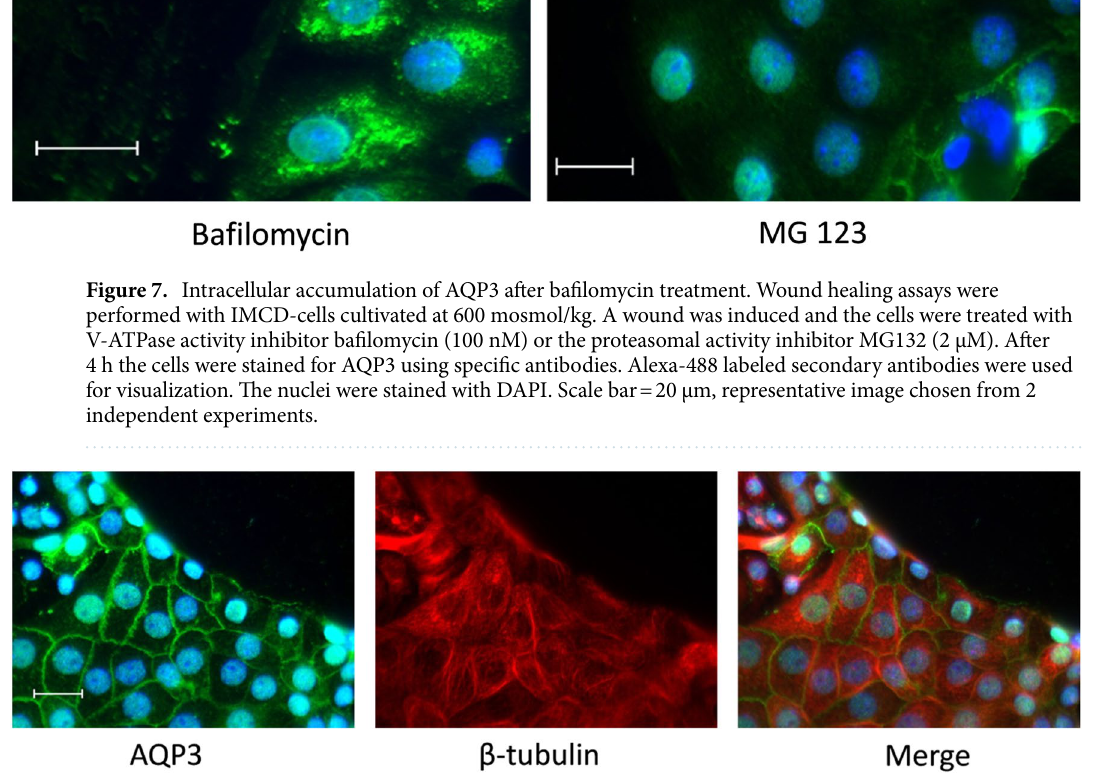
Figure 8. The treatment with dbcAMP prevented the degradation of AQP3. Wound healing assays were performed with IMCD-cells cultivated at 600 mosmol/kg. A wound was induced and after 4 h the cells were stained for AQP3 and beta tubulin using specific antibodies. During this period of time the cells were treated with dbcAMP (250 µM). Alexa-488 (green) and Alexa-568 (red) labeled secondary antibodies were used for visualization. The nuclei were stained with DAPI. Scale bar = 20 µm, representative image chosen from 2 independent